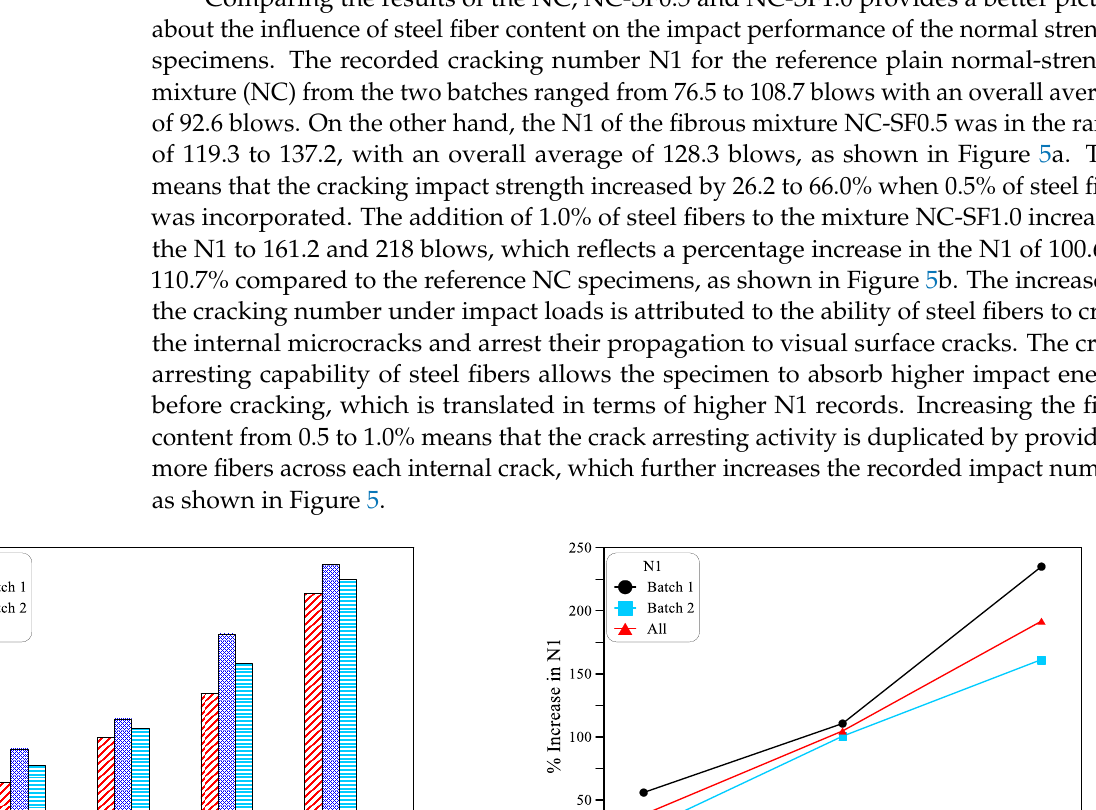
Figure 6a. Based on the failure impact number records of the reference plain NC speci- mens, which were 80 and 110 with an average of 95, a percentage increase of approxi- mately 114% was attained in the N2 when 0.5% of SF was used in the mixture. On the other hand, the percentage increase in N2 based on the average records was approxi- mately 374% for a fiber content of 1.0%. Hence, it can be said that using 0.5% SF dupli- cated the failure impact number, while incorporating 1.0% of SF increased the failure impact resistance to approximately four times that of the plain specimens. It is obvious that the percentage increase in the N2 due to fiber incorporation was much higher than that of the N1. A similar result was also highlighted by previous studies [59,82,83] and was attributed to the functional sequence of SF as crack bridging elements. Before cracking, a few tiny internal cracks are formed under the effect of the first few impact blows. These cracks are small in size compared to the dimensions of the mixture’s steel fiber. Steel fibers cross these cracks and arrest their widening when their size becomes within the fiber s’ capability, which limits the fiber s’ activity to its minimum. On the other hand, after the surface cracks become visible, the matrix is already full of irregular grids of internal cracks, where fibers are crossing and bridging these cracks at their full capac- ity until failure. Hence, fibers are fully functional at the post-cracking loading phase, which increases N2 records hugely compared to plain specimens.